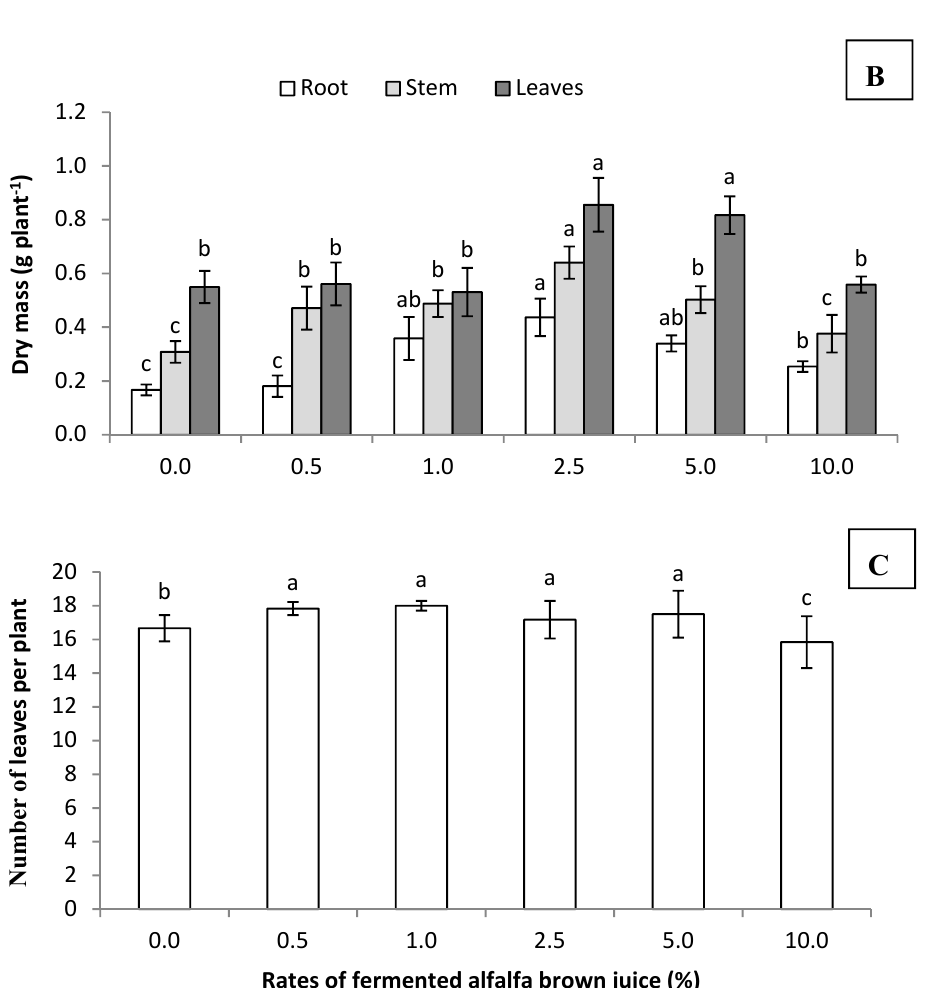
Figure 2. Fresh ( A ) and dry ( B ) masses and the number of leaves ( C ) of different plant tissues (roots, stems, and leaves) of Celosia plants sprayed at different rates of fermented alfalfa brown juice. Sample size ( n = 6). Different letters above the same columns show significant differences at the level of p < 0.05.